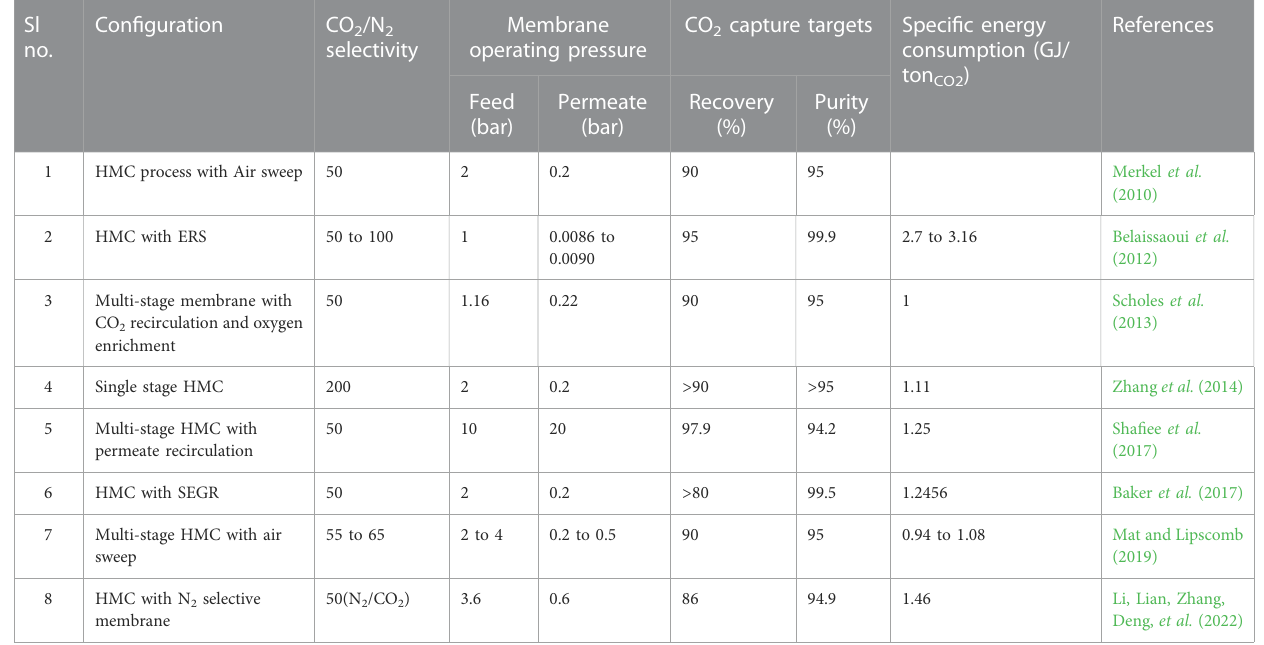
TABLE 1 HMC process CO 2 capture target and energy penalty comparisons. Sl